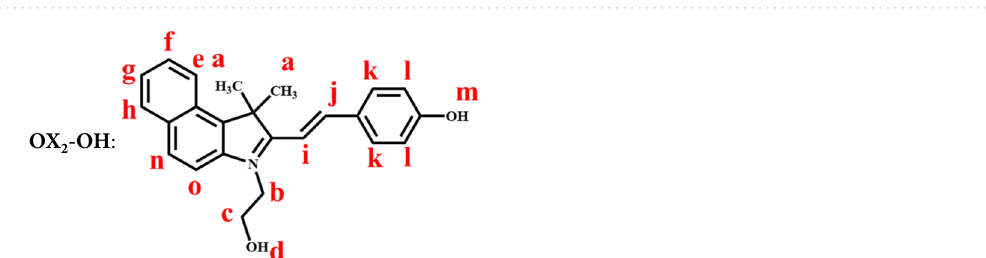
Figure 3. Schematic illustration for synthesis of oxazolidine derivatives from different aldehyde and indolium